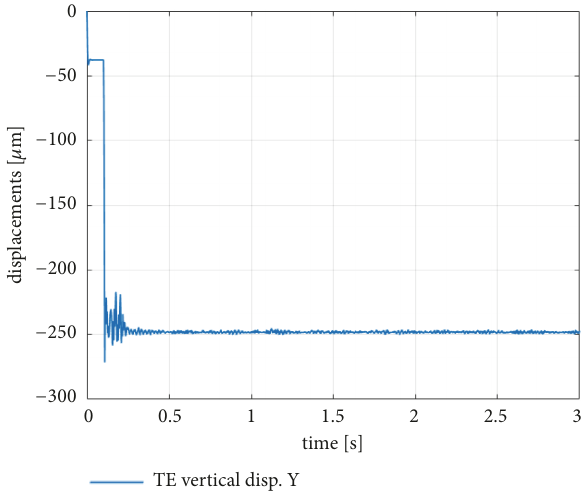
Figure 11: Predicted rotor vertical displacements during a landing test (DE node).